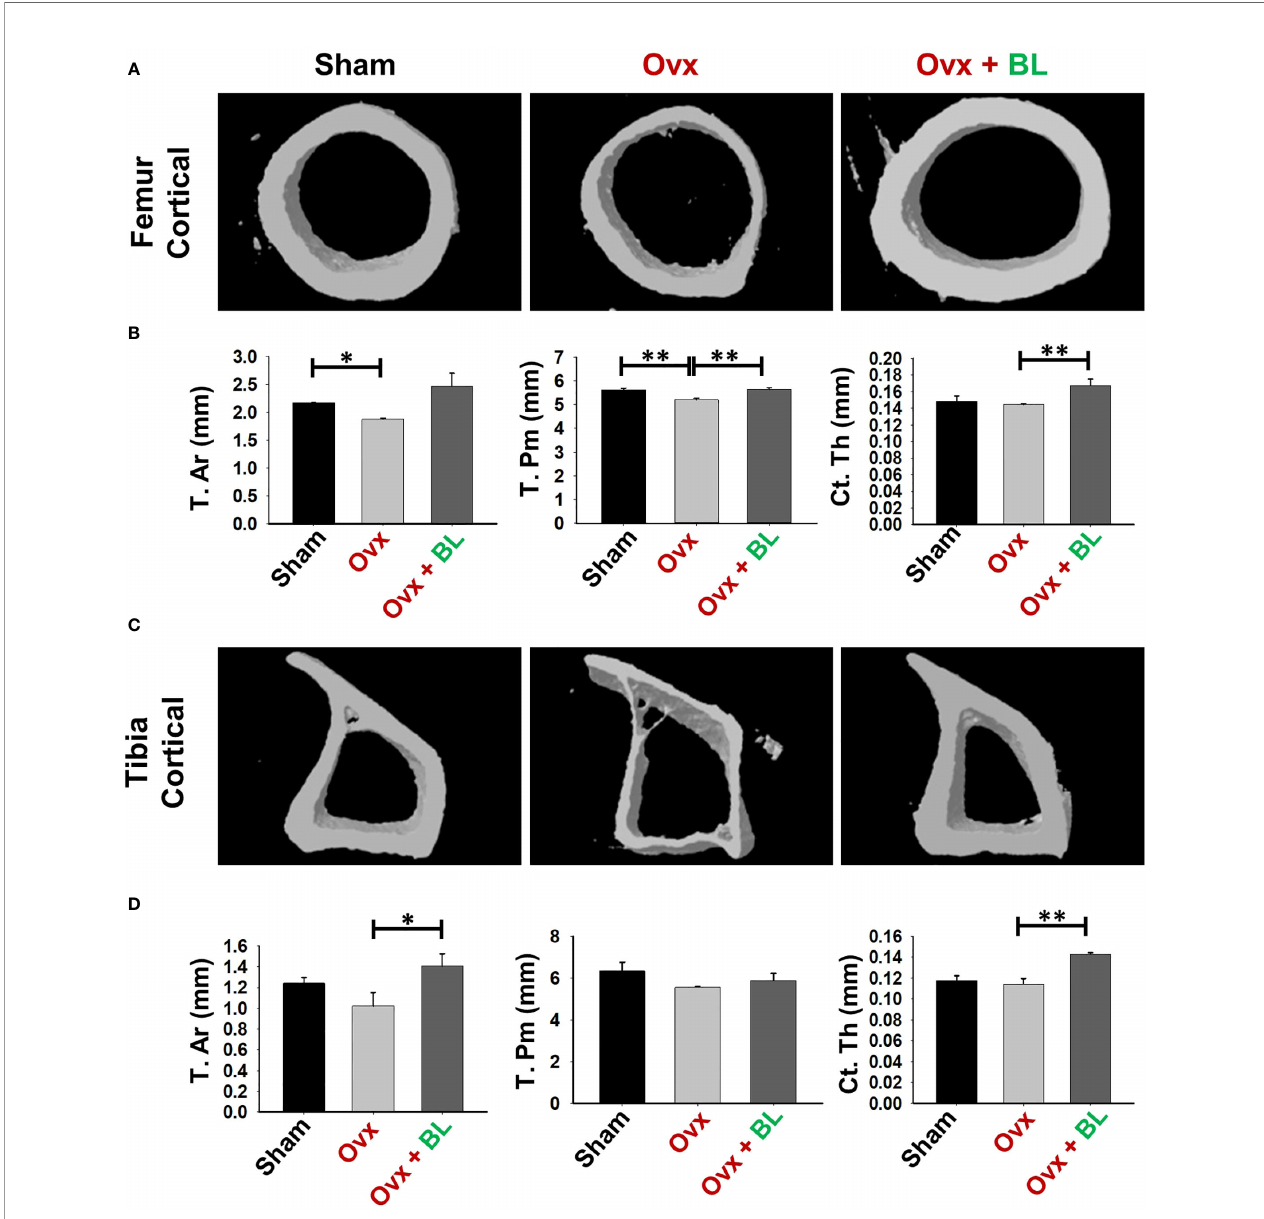
FIGURE 7 | BL administration improves cortical bone microarchitecture. 3D uCT reconstruction of femur cortical and tibia cortical of all groups. (A) Bone micro- architecture of femur cortical. (B) Histomorphometric parameters of femur cortical. (C) Bone micro-architecture of tibia cortical. (D) Histomorphometric parameters of tibia cortical. Histomorphometric parameters of tibia cortical. Tt. Ar., total cross-sectional area; T. Pm., total cross-sectional perimeter; Ct. Th., cortical thickness. The results were evaluated by ANOVA with subsequent comparisons by Student ’ s t-test for paired or non-paired data. Values are reported as mean ± SEM. The above graphical representations are indicative of one independent experiment, and similar results were obtained in two different independent experiments with n = 6. Statistical signi fi cance was considered as p ≤ 0.05 (*p ≤ 0.05, **p ≤ 0.01) with respect to indicated mouse